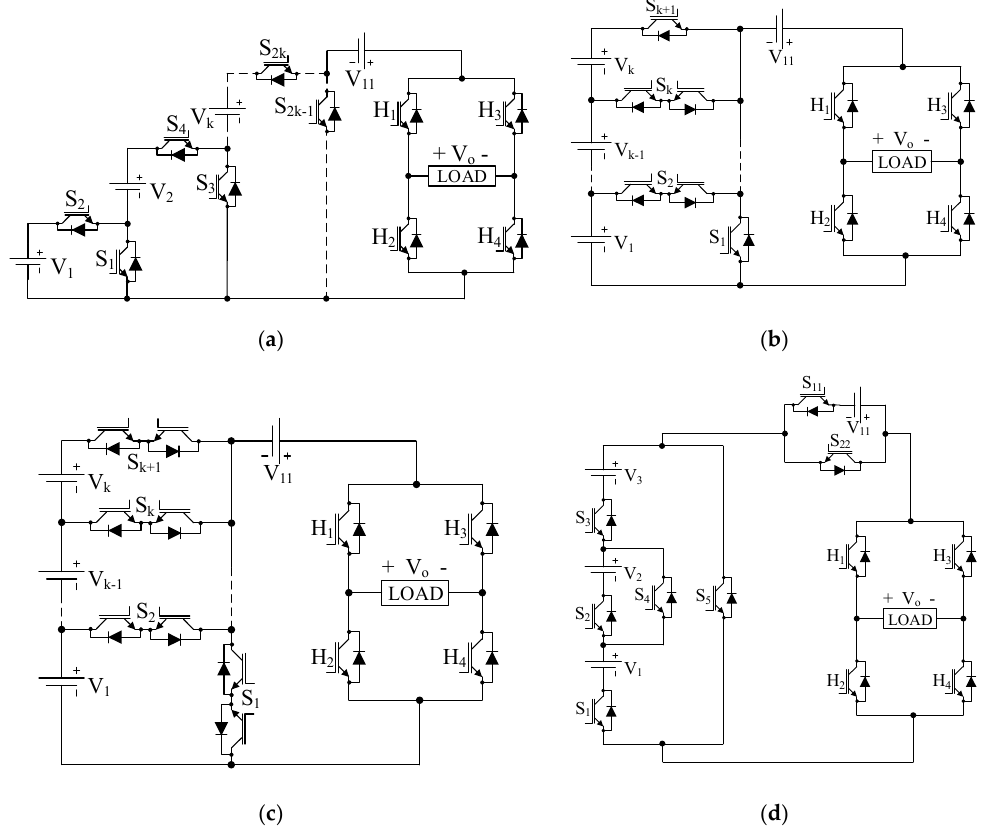
Figure 3. The hybrid MLI topologies proposed in ( a ) [11]; ( b ) [12]; ( c ) [13]; and ( d ) [14].